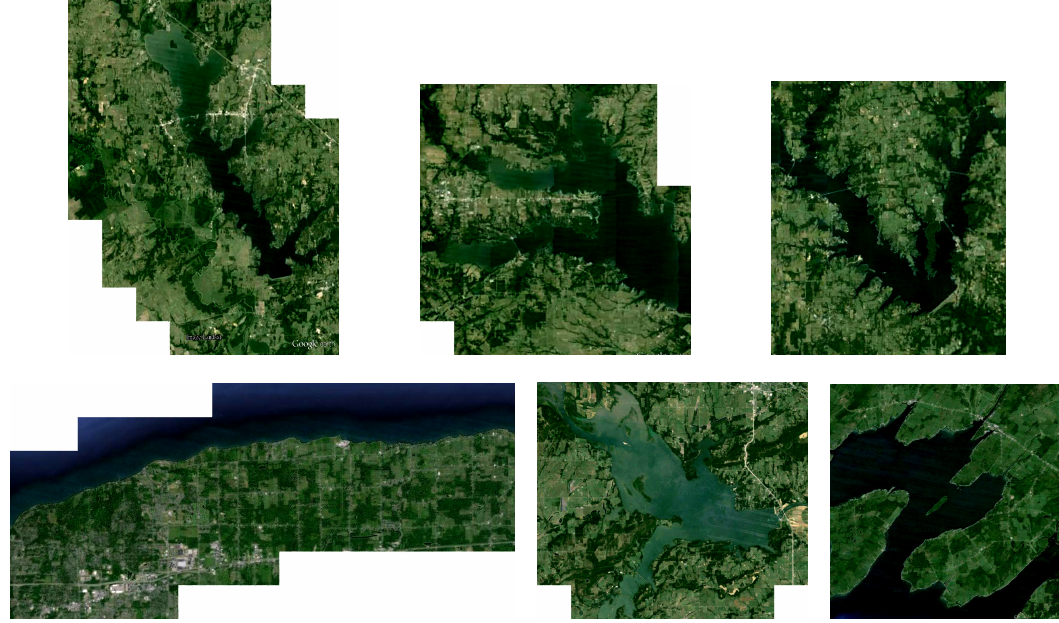
Figure 7. The remotely sensed images taken from Google Earth corresponding to the scenes shown in Figure 5 (for visualization, the histogram of the image has been stretched).